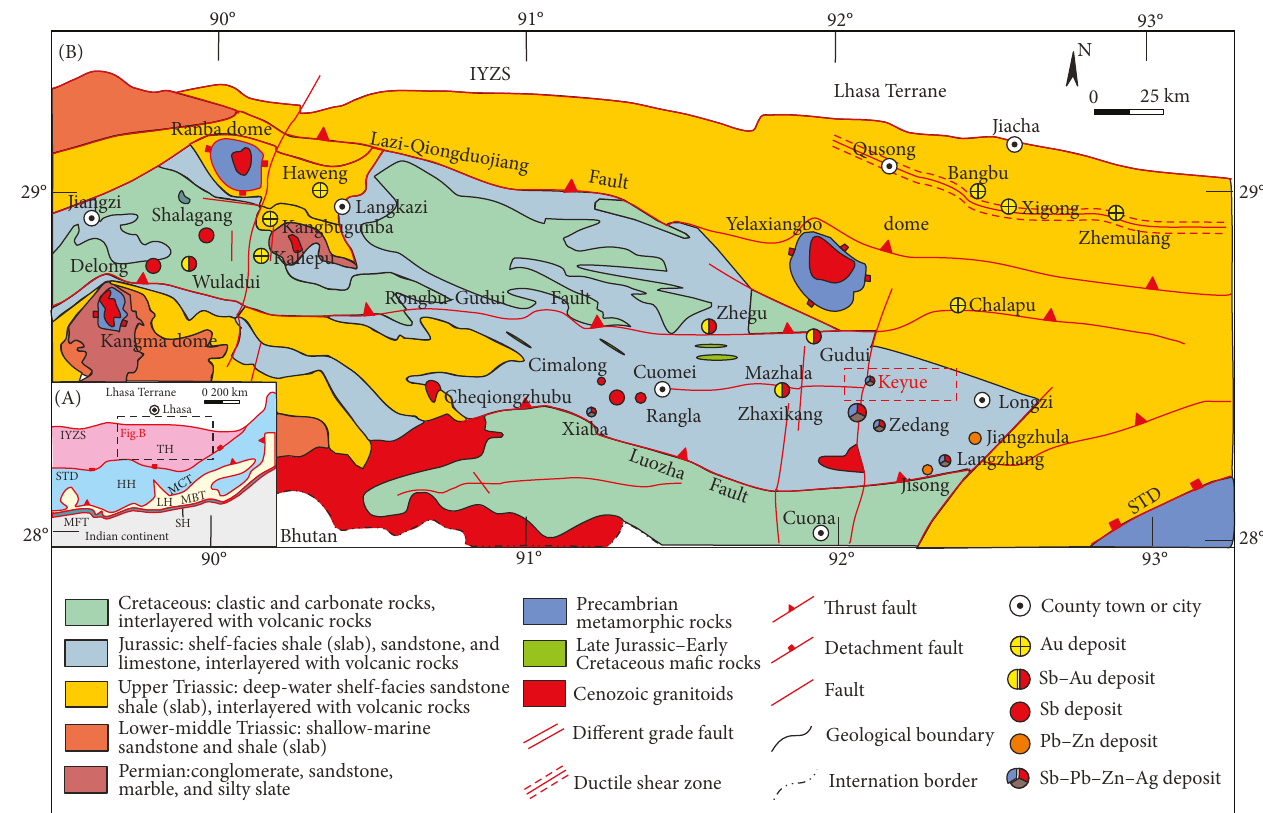
Figure 1: (a) Tectonic framework of the Himalayan Terrane (modi fi ed from Yin [5] and Wang et al. [25]). (b) Regional geological map of the North Himalayan Metallogenic Belt (modi fi ed from Zheng et al. [1] and Wang et al.